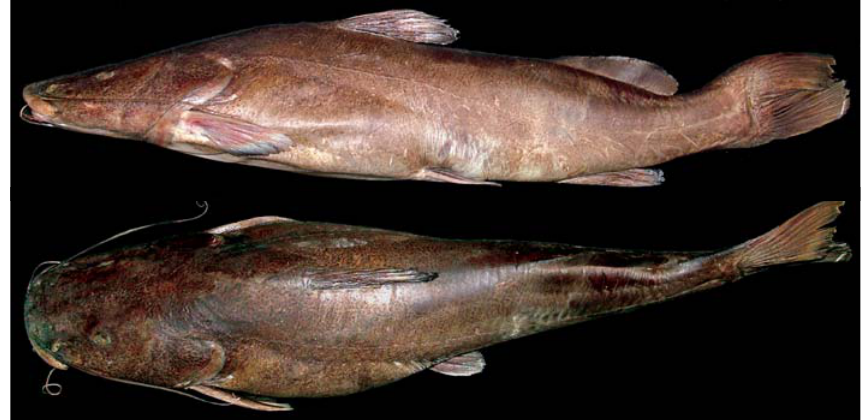
Fig. 9. Lateral and dorsal views of S. melanodermatum holotype. MZUSP 87983, 530 mm SL, municipality of Quedas